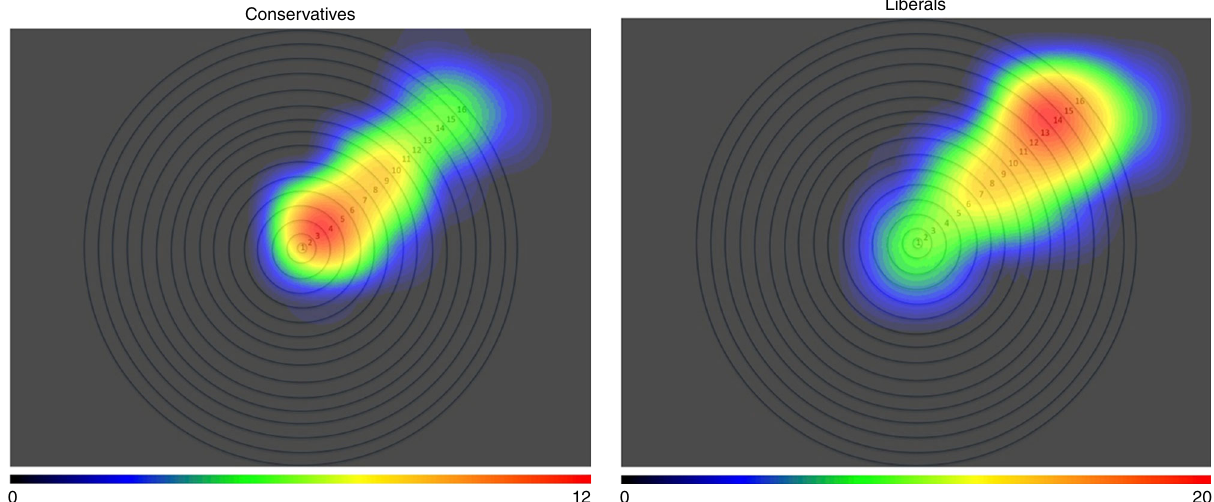
Fig. 5 Heatmaps indicating highest moral allocation by ideology, Study 3a. Source data are provided as a Source Data fi le. Note . The highest value on the heatmap scale is 20 units for liberals, and 12 units for conservatives. Moral circle rings, from inner to outer, are described as follows: (1) all of your immediate family, (2) all of your extended family, (3) all of your closest friends, (4) all of your friends (including distant ones), (5) all of your acquaintances, (6) all people you have ever met, (7) all people in your country, (8) all people on your continent, (9) all people on all continents, (10) all mammals, (11) all amphibians, reptiles, mammals, fi sh, and birds, (12) all animals on earth including paramecia and amoebae, (13) all animals in the universe, including alien lifeforms, (14) all living things in the universe including plants and trees, (15) all natural things in the universe including inert entities such as rocks, (16) all things in